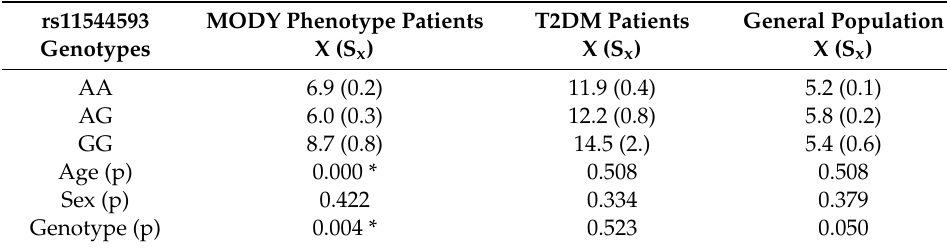
Table 3. Mean blood glucose levels (mM /